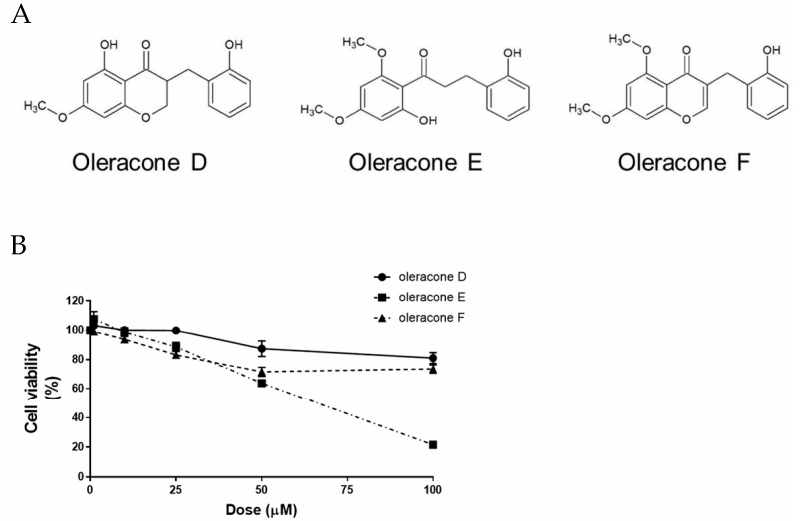
Figure 1. Structure and the effects of oleracones on cell viability. ( A ) The structure of oleracones D, E, and F are shown. ( B ) HBMVECs were pretreated with oleracones at the concentrations indicated 1 h prior to treatment with TNF- α (10 ng/mL, for 24 h). The cell viability was determined by the MTT assay.